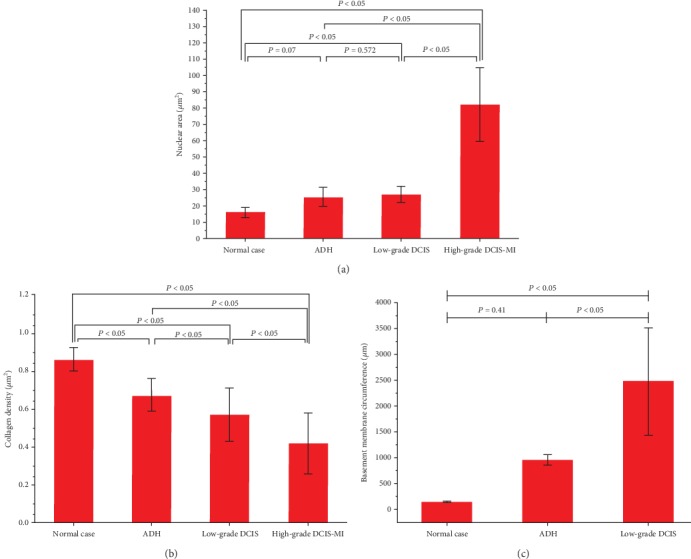
Nuclear area (a) and collagen density (b) of normal breast tissue versus ADH and low-grade DCIS as well as high-grade DCIS-MI; the basement membrane circumference (c) of normal breast tissue versus ADH and low-grade DCIS; error bars: standard deviation.